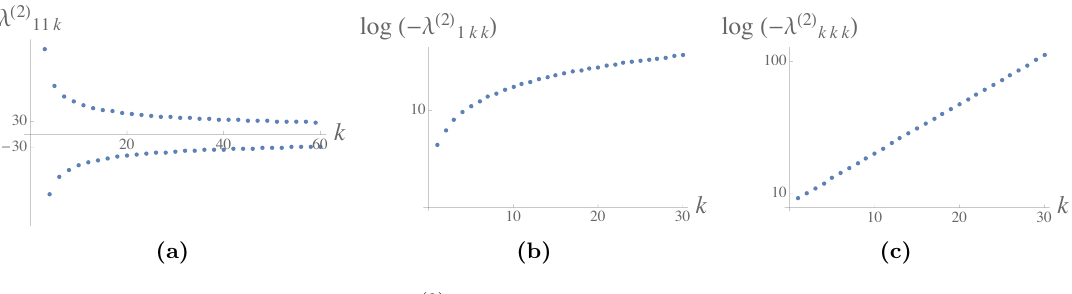
Figure 9. The bulk cubic couplings (cid:21) (2) are log